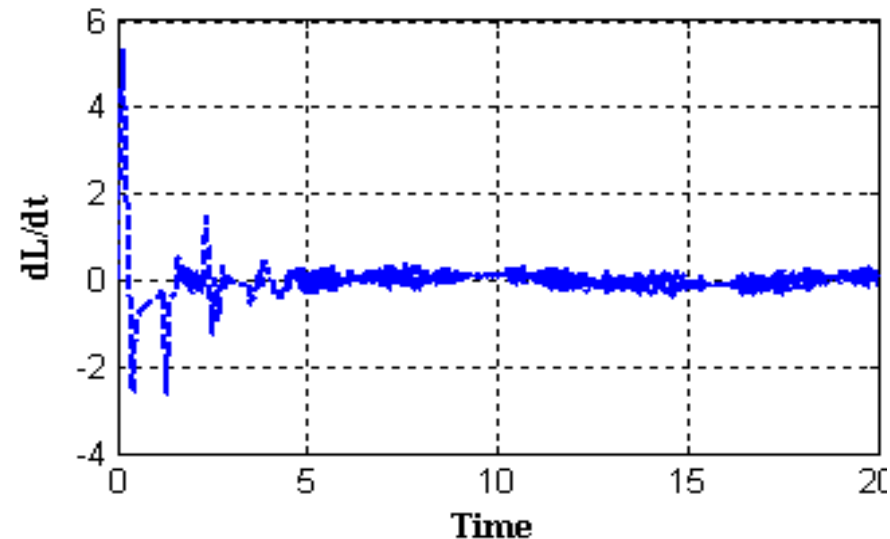
Figure 8. The derivative of the generalized disturbance.